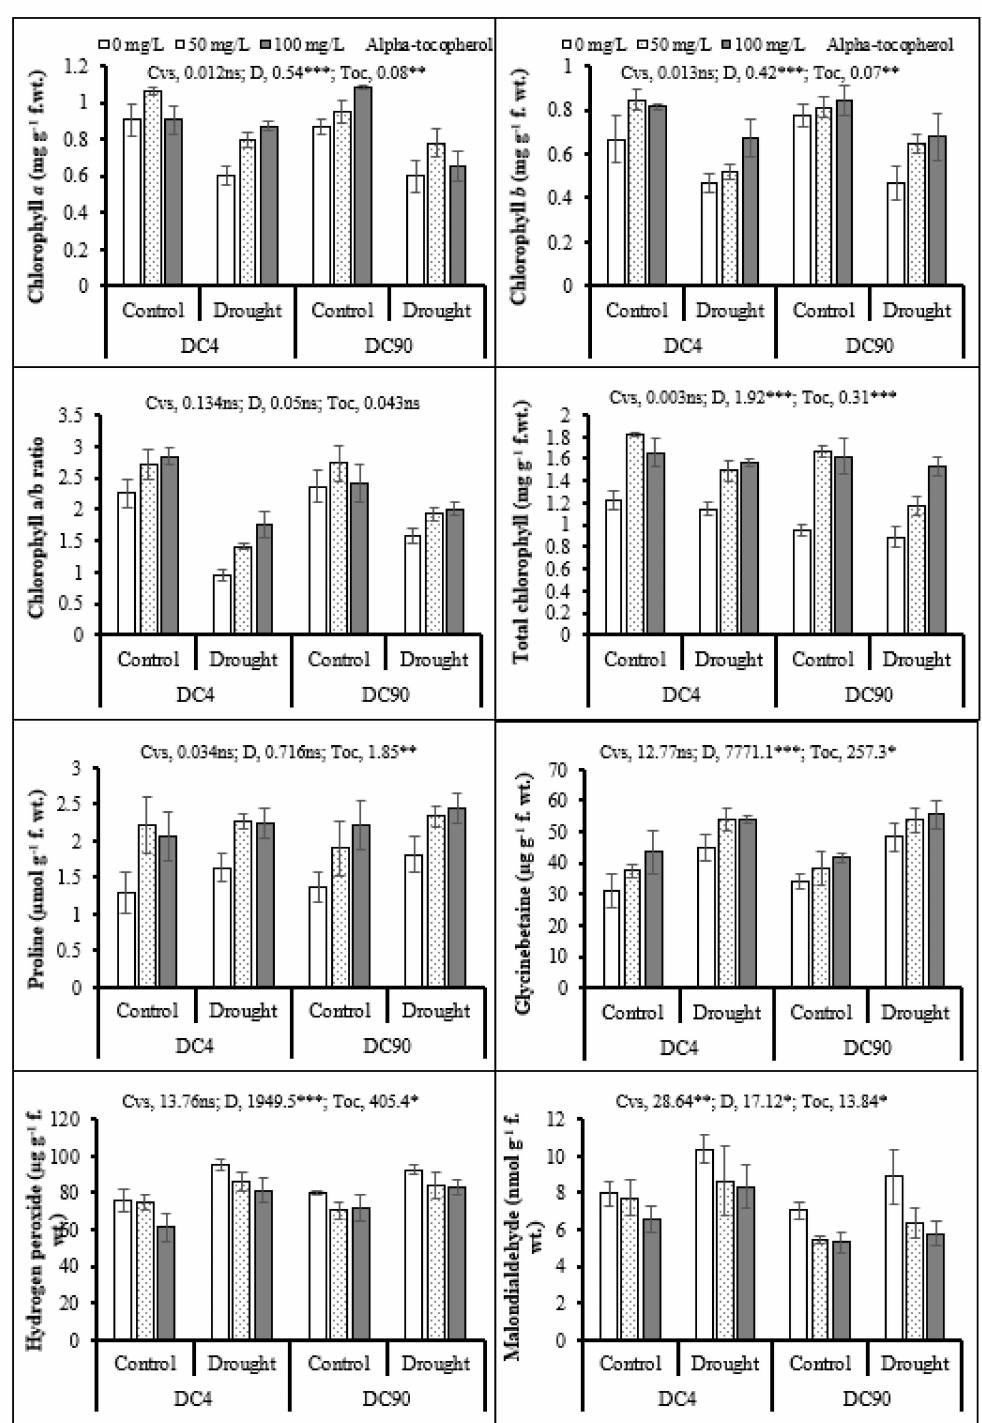
Figure 2. Effect of different levels of alpha-tocopherol on chlorophyll (a, b, a/b ratio, total) content, proline, glycinebetaine (GB), hydrogen peroxide and malondialdehyde content of 51-day-old carrot cultivar grown under control (normal watering) and drought (50% field capacity) stressed environments. Bars sharing different letter(s) for each parameter are significantly different from each other according to Duncan’s multiple range test ( p < 0.05). All the data represented are the average of three replications ( n = 3). Error bars represent standard deviation (SD) of three replicates. ns, non-significant, *, ** and ***; significant at 0.05, 0.01 and 0.001